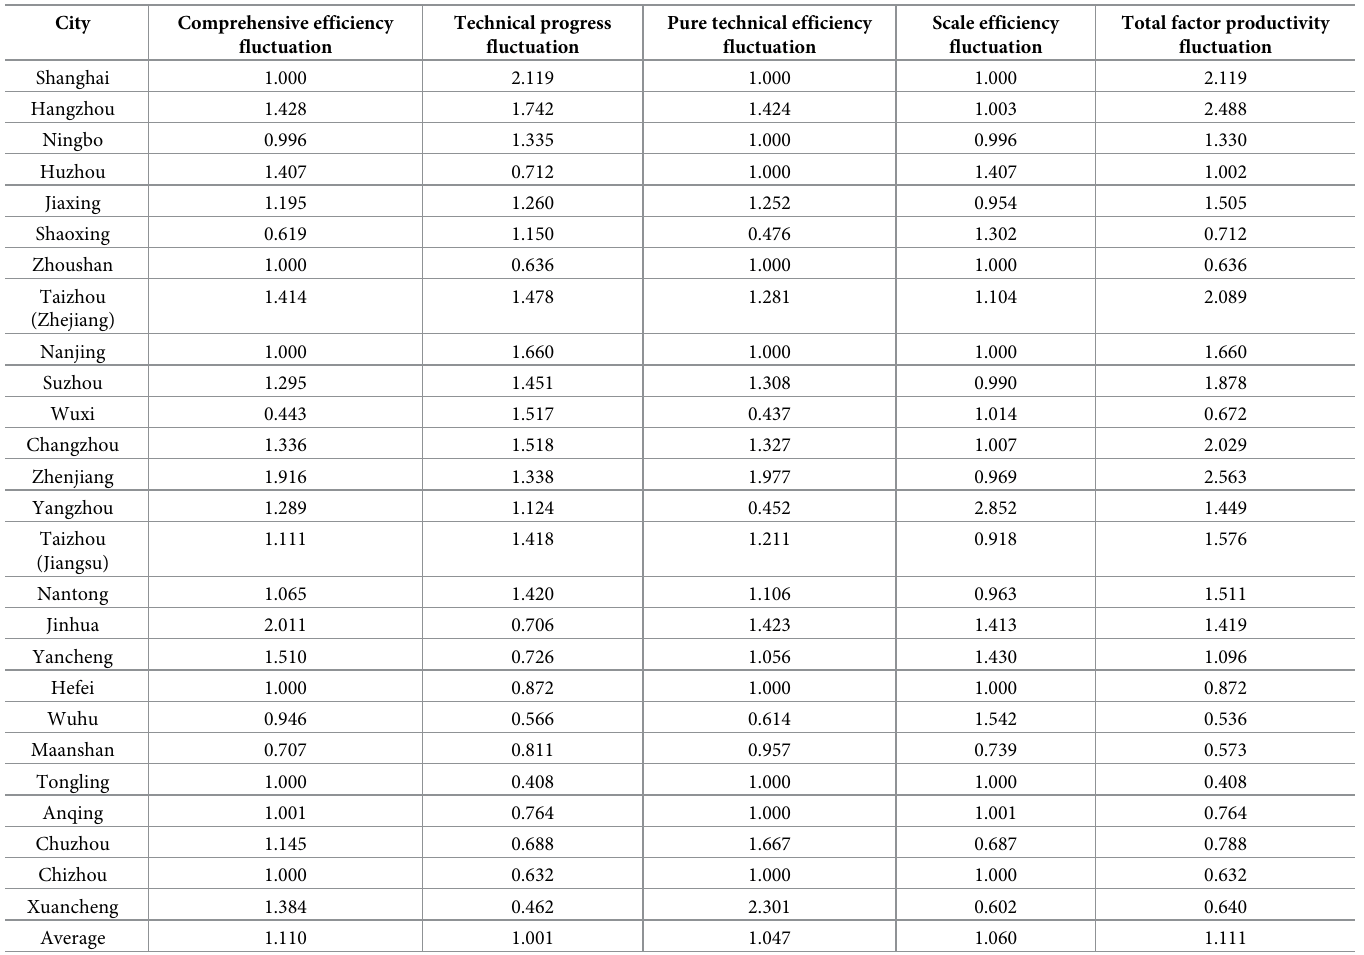
Table 5. The Malmquist index of YRDUA during 2000 to 2015.